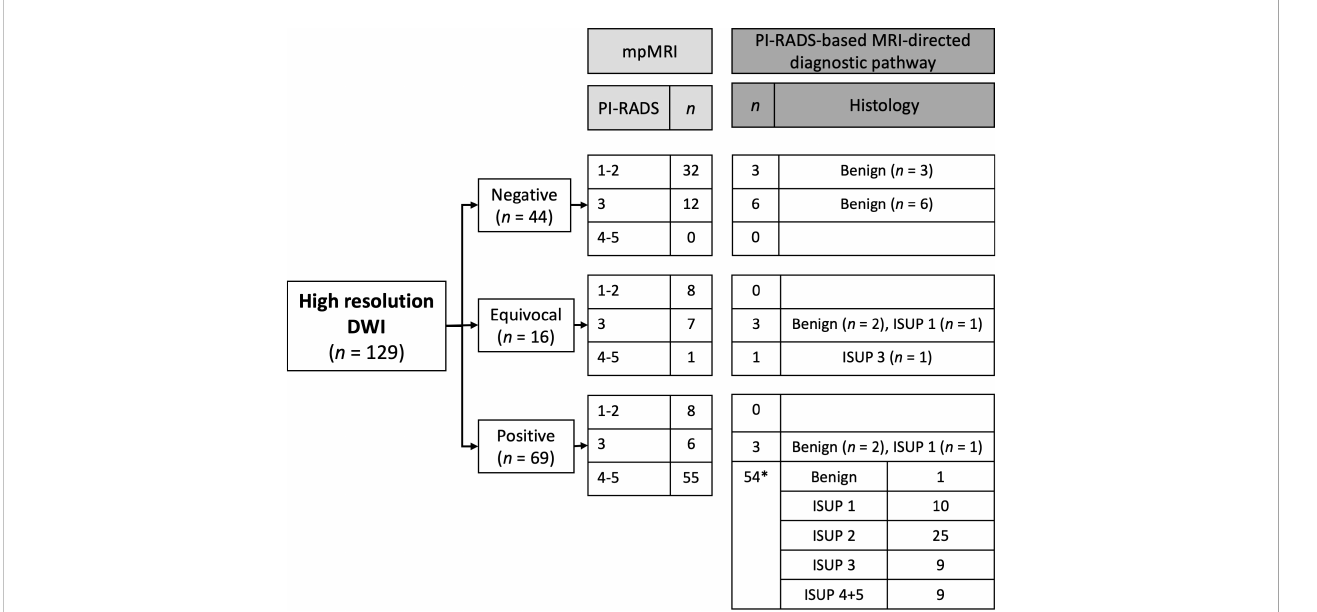
FIGURE 5 Results from the independent retrospective interpretation of high-resolution DWI-only compared to PI-RADS (mpMRI) and biopsy results. *No biopsy performed in one patient because of comorbidity and a small lesion at MRI. The patient was referred to PSA monitoring and was not re-referred within the 55 months he was followed.